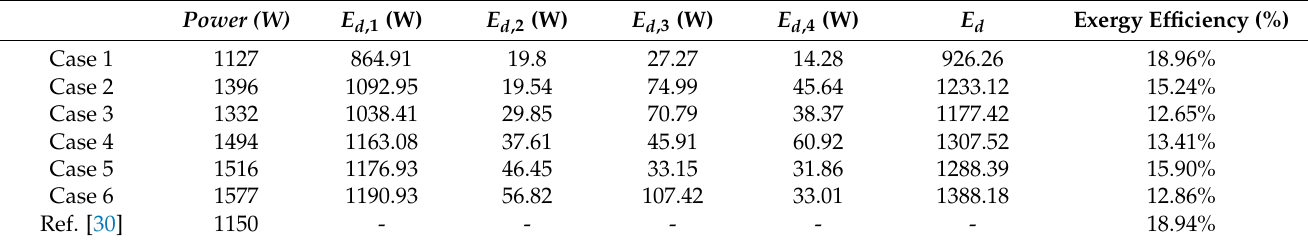
Table 7. Exergy destruction under six cases.